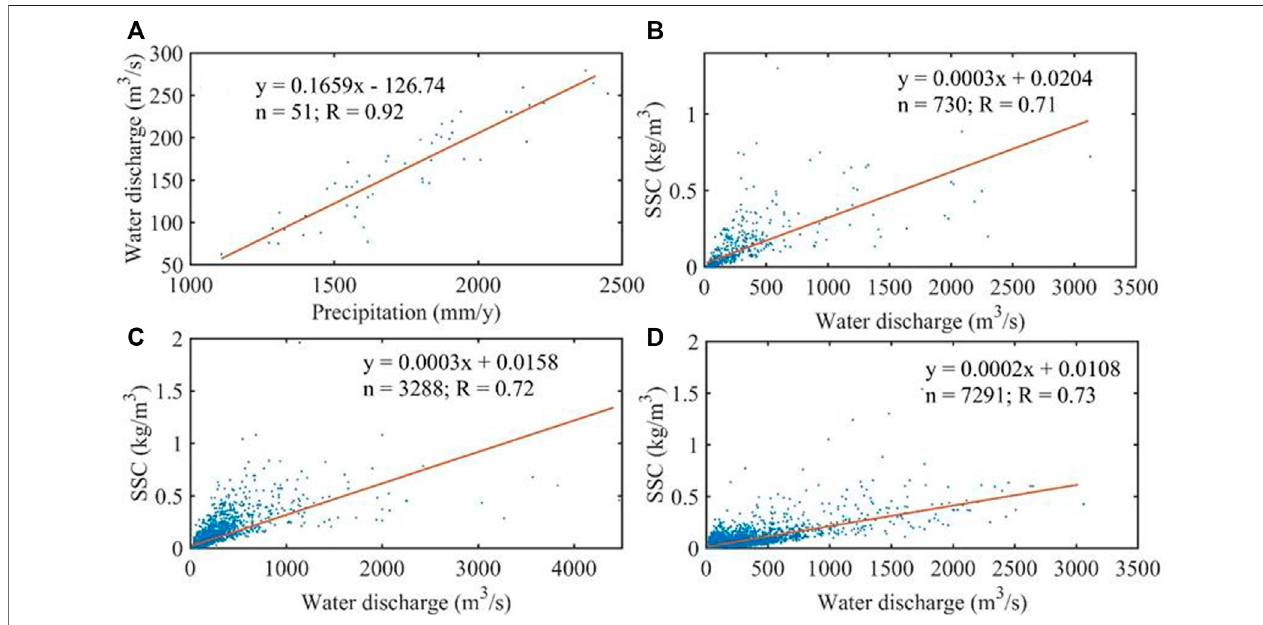
FIGURE 10 | Water discharge and precipitation from 1970 to 2020 (A) : SSC and water discharge (B – D) indicate 1965 – 1966, 1976 – 1984, and 2001 – 2020).